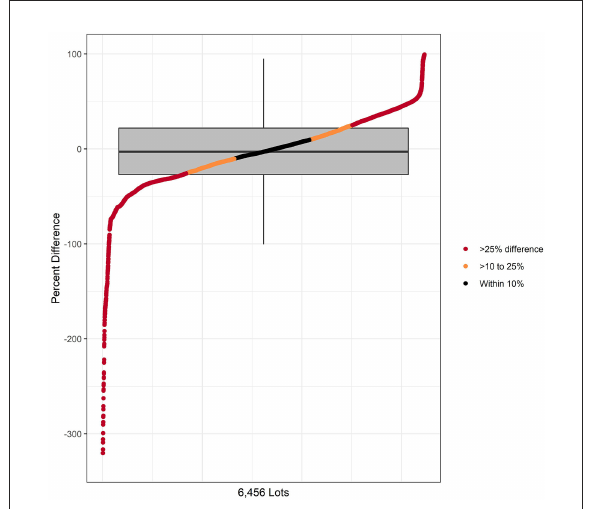
FIGURE2 Comparison of CDoA and nDDD at the lot level with the difference expressed as the percentage of CDoA for each lot. The distribution on the X axis represents the values for 6,456 lots after 4 lots were omitted for truncation of the Y axis. Data are reported as both a distribution and as a box and whiskers plot The box and whisker plot corresponds only to Y axis values for percent difference.